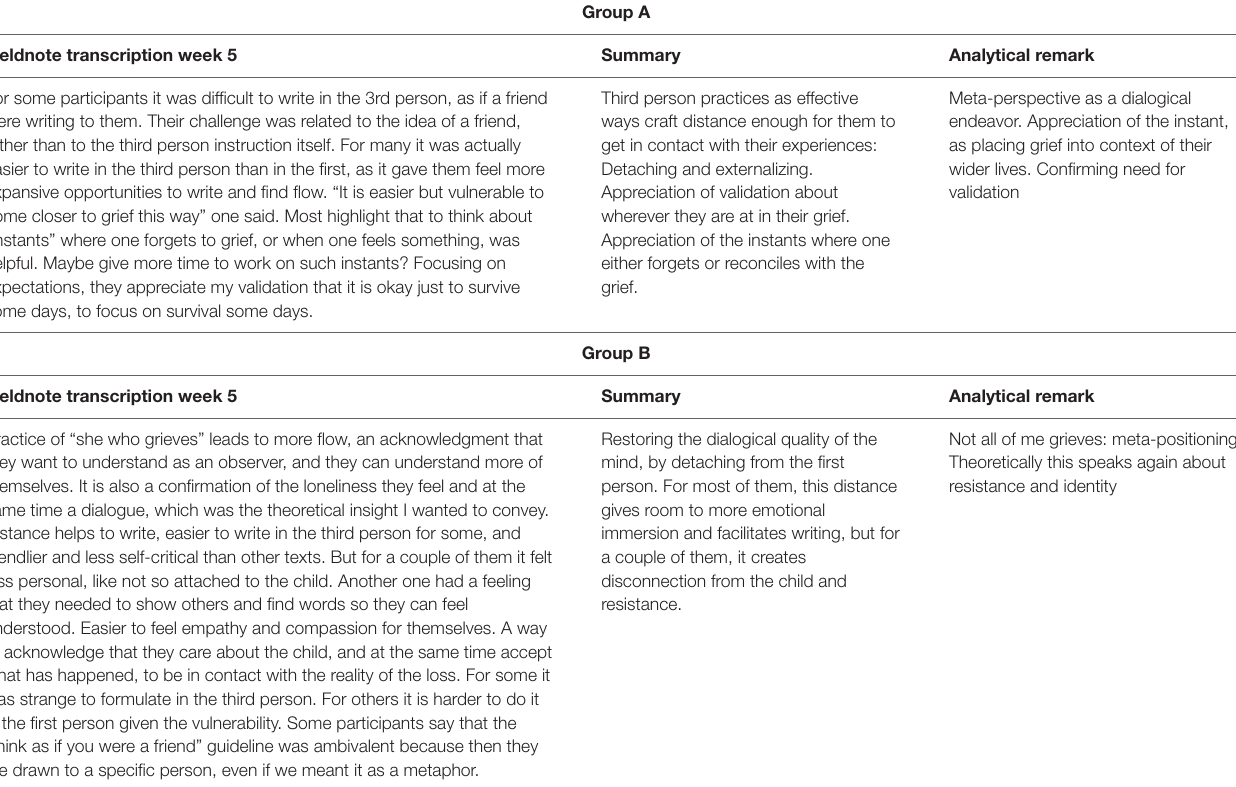
TABLE 2 | Example of meaning condensation and structure of the